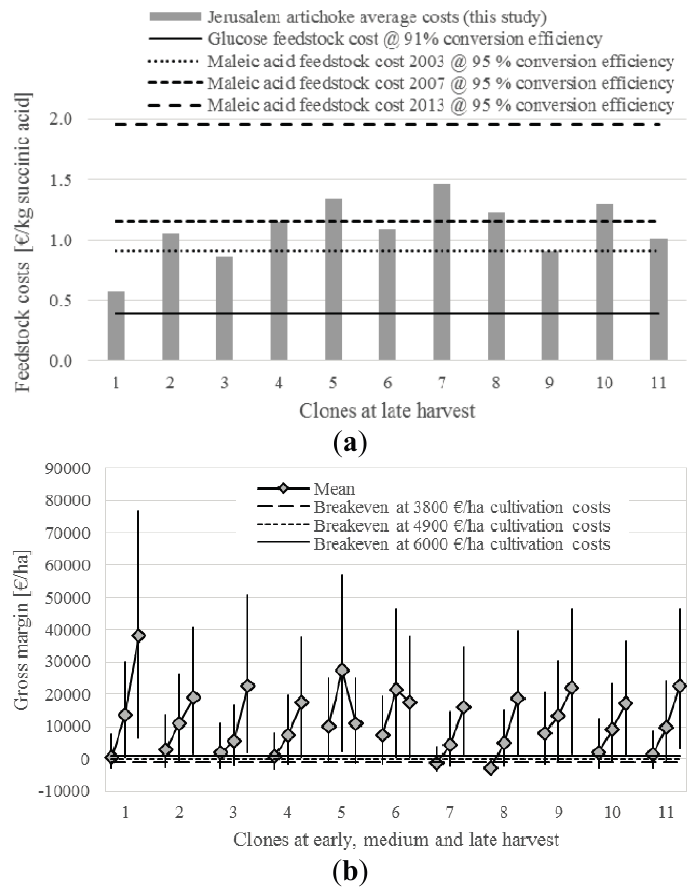
Figure 2. ( a ) Feedstock costs per kilogram succinic acid produced and ( b ) average gross margin of biorefinery utilization at three harvest occasions, of different clones of Jerusalem artichoke. Solid lines in ( a ) represent feedstock costs for glucose as a substrate for bio-based succinic acid fermentation, while the dotted lines show the development of feedstock costs for maleic acid as from petroleum origin [99,100]; In ( b ) grey markers represent average gross margin and black bars represent range according to variation in original chemical analyses and low/high variation for processing efficiencies and